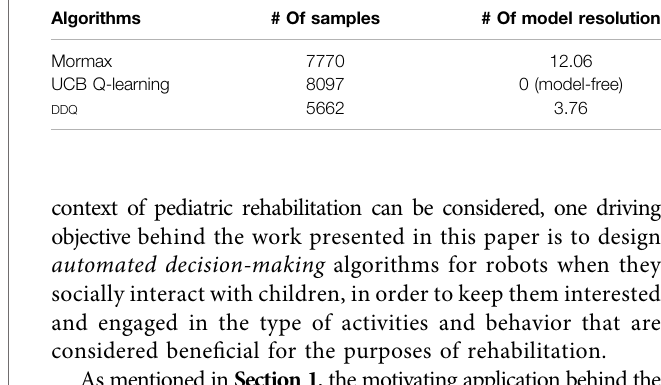
algorithm resolves the model through value-iteration part is 3.76 on average.